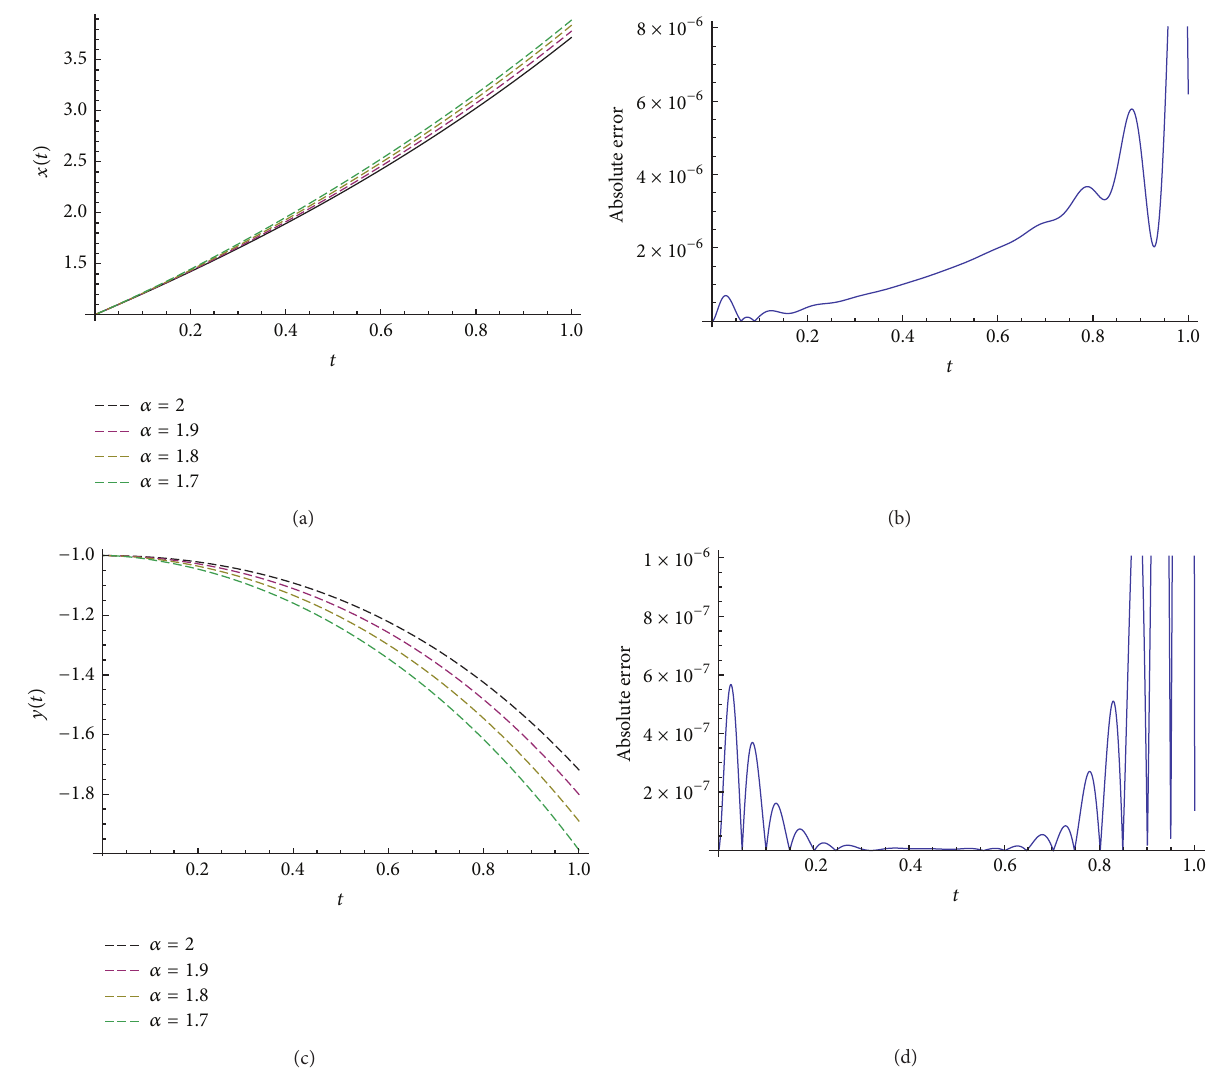
Figure 3: Graphical results for Example 3 when 𝛼 1 = 𝛼 2 = 𝛼 = 2, 1.9, 1.8 , and